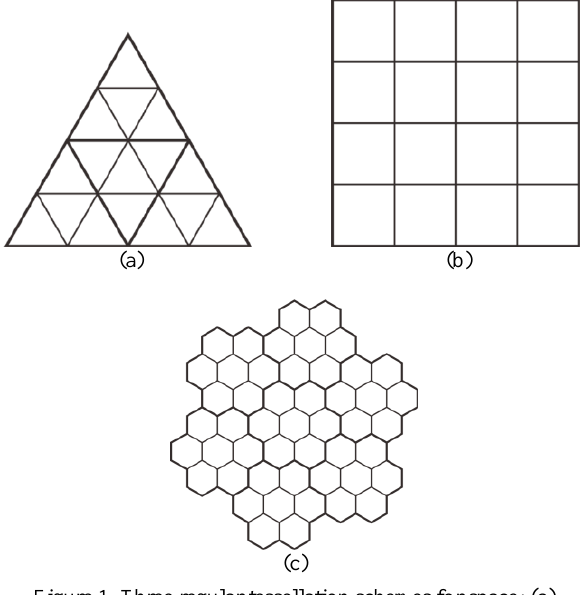
Figure 1. Three regular tessellation schemes for space: (a) triangles; (b) squares; (c)